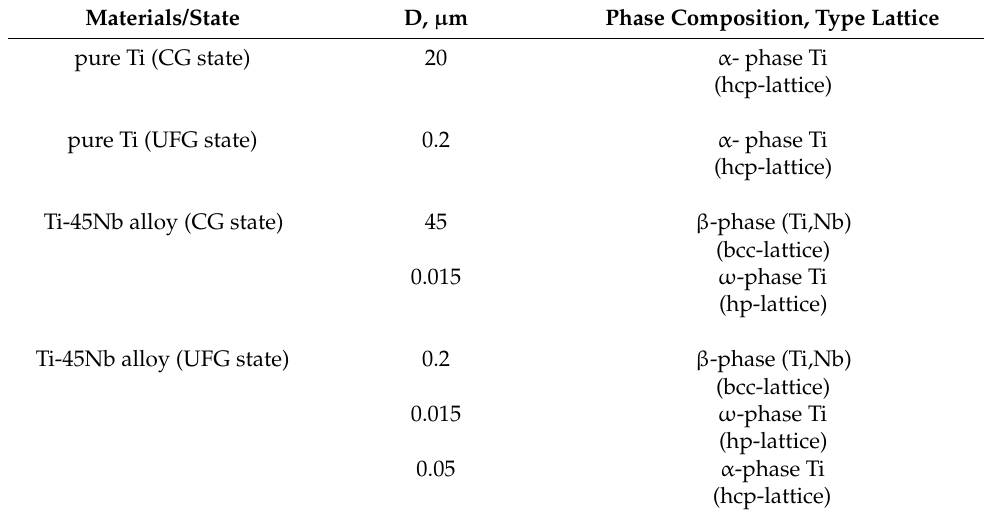
Table 1. Structural parameters and phase composition in pure titanium and Ti-45Nb alloy in the CG and UFG states.